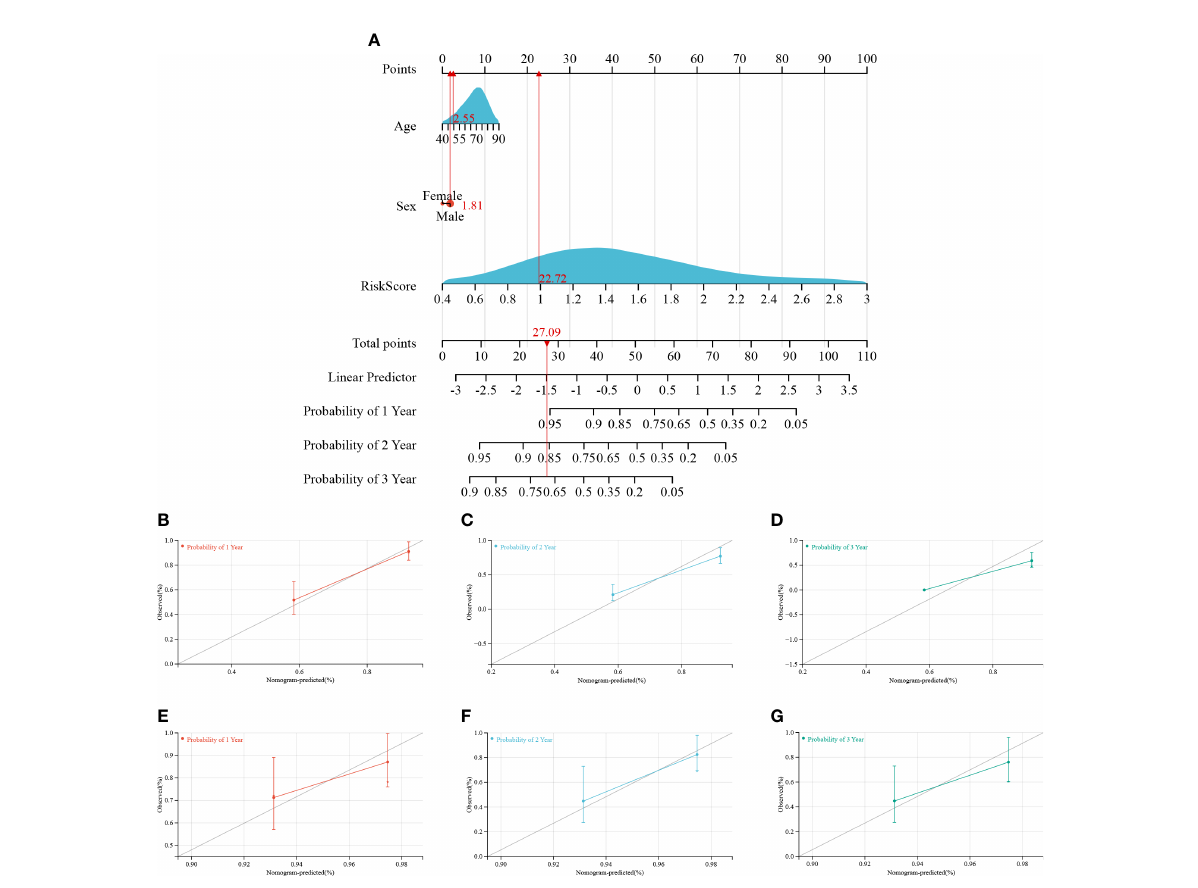
FIGURE 8 Construction and calibration of the nomogram. (A) Nomogram integrating risk score and clinical features, (B – D) calibration of the nomogram at 1-, 2-, and 3- years in the training cohort, and (E – G) calibration of the nomogram at 1-, 2-, and 3- years in the veri fi cation